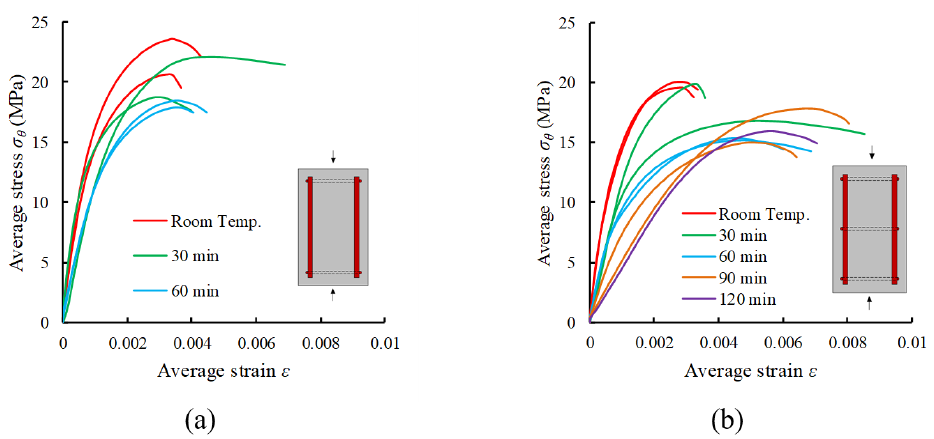
Figure 8. Average stress vs stress curves for reinforced concrete stub columns: a) two ties; b) three ties.